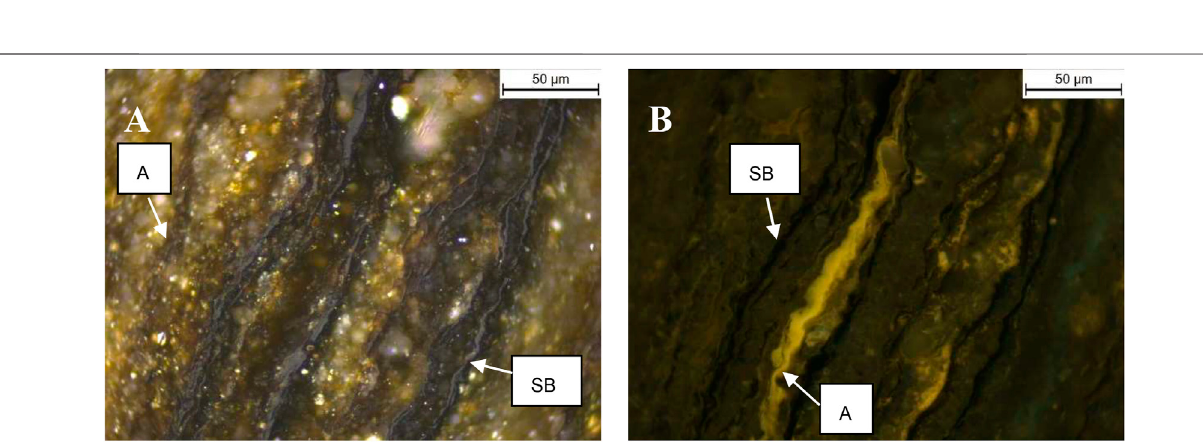
Frontiers in Earth Science |